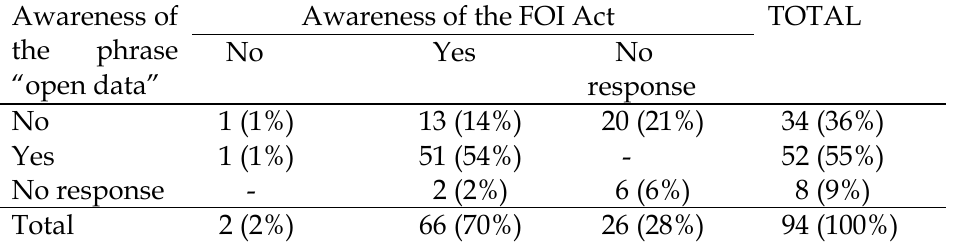
Table 3: Cross-Tabulation of Respondent’s Awareness of Open Data and the FOI Act Awareness of